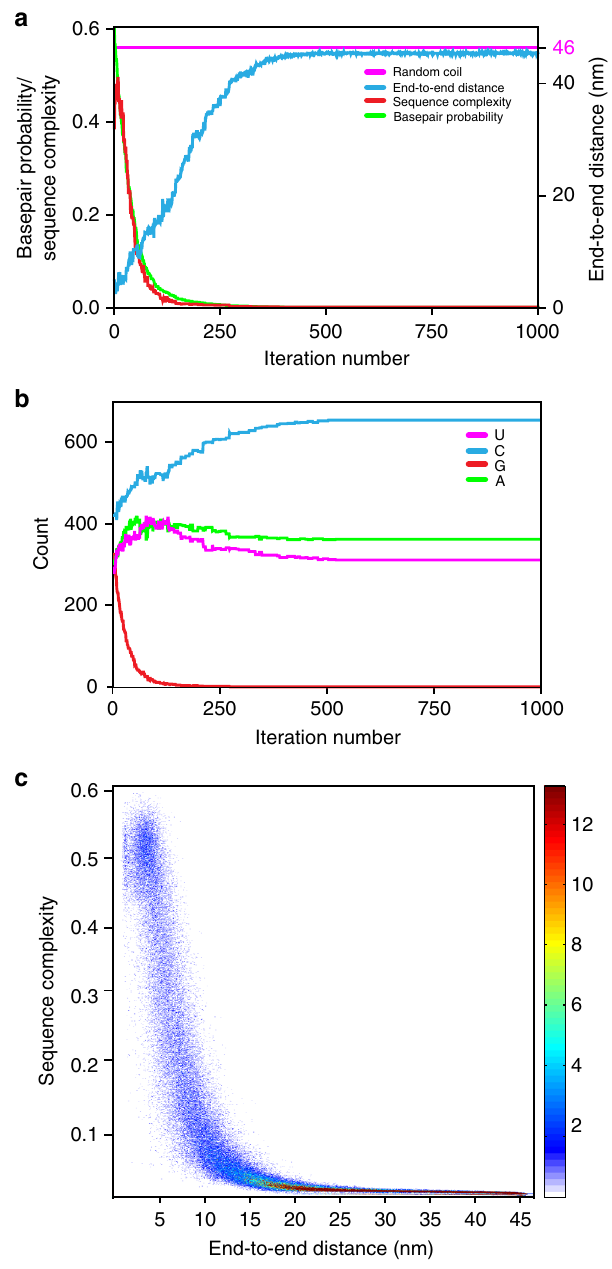
Fig. 5 Sequence features of intrinsically unstructured RNA sequences. The entire 1327-nt-long GAPDH mRNA sequence was evolved in silico by a genetic algorithm to minimize average basepairing probability and produce intrinsically unstructured sequences. a End-to-end distance (blue), sequence complexity (red), and mean base pair probability (green) as functions of iteration number are shown for a single representative in silico sequence evolution experiment. The distance predicted for a 1327-nt-long RNA in a random-coil conformation is shown by the magenta line. b Evolution of nucleotide composition in a single representative in silico sequence transformation experiment shown in a . Frequency of adenosine (A), cytidine (C), guanosine (G), and uridine (U) are shown in magenta, blue, red, and green, respectively. c Surface contour plots generated from 500 independent in silico sequence evolution experiments show changes of sequence complexity ( y -axis) as a function of end-to-end distance ( x -axis). The range of sequence complexity from 0 to 0.6 was separated into 2000 bins. The range of end-to-end distance from 1.6 to 46 nm was separated into 500 bins. The resulting heat map shows the frequency